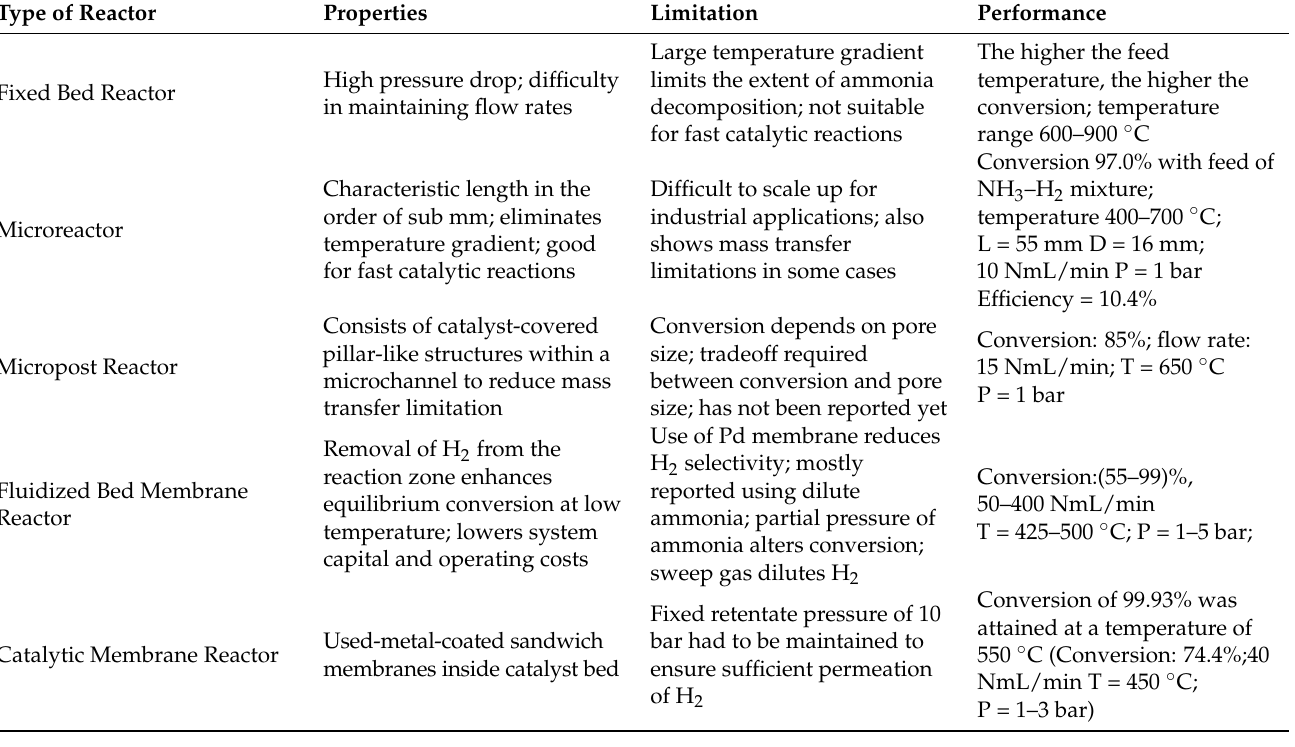
Table 9. Ammonia decomposition reactors, their performance, and their reaction temperatures. Reprinted with permission